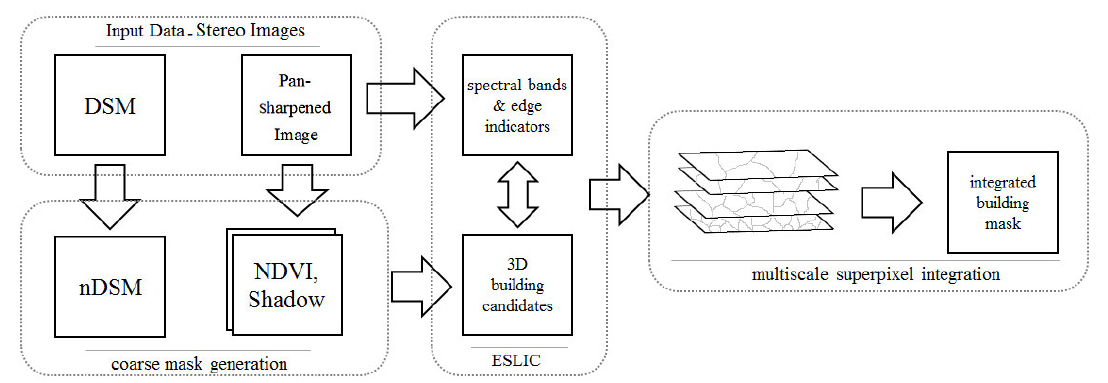
Figure 5. Workflow of building mask extraction supported by multi-scale